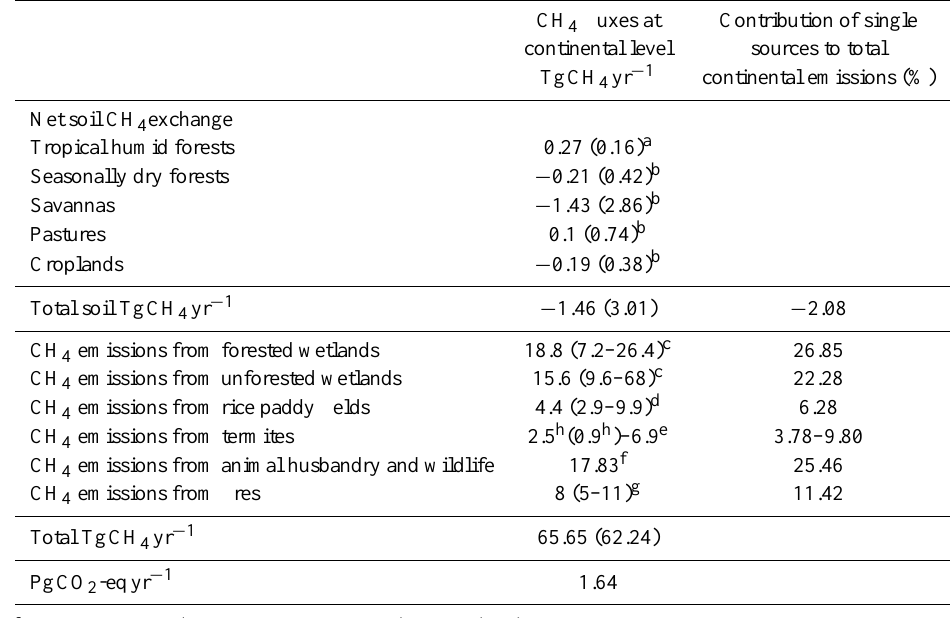
Table 10. CH 4 fluxes from biogenic processes and fires. Total surfaces derived from